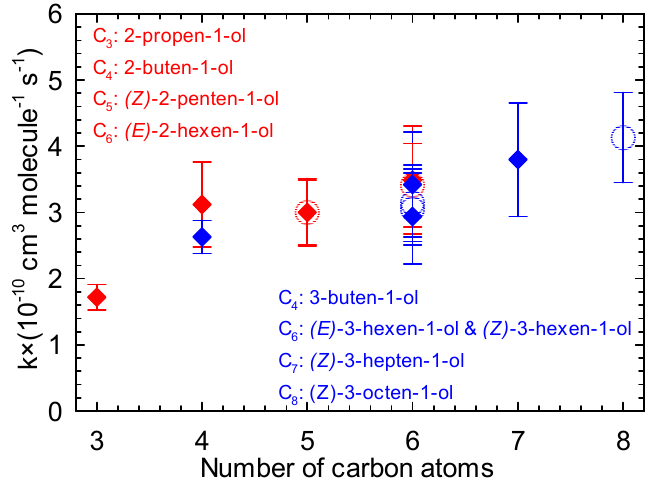
Figure 6. Rate constants of the reaction of Cl atoms with 2-alken-1-ols (red) and 3-alken-1-ols (blue) vs. number of carbon atoms (the open circles represent the values of the current study).